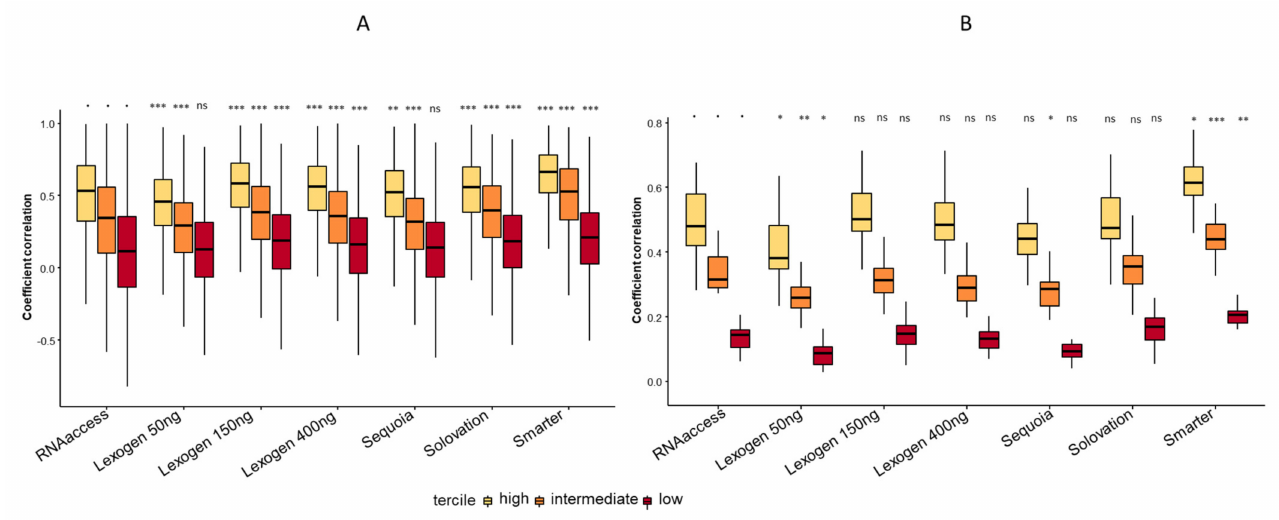
Figure 3. Comparison of sequencing kits with Truseq. ( A ) Gene-wise correlation of gene expressions between Truseq and other sequencing kits. Coefficient correlations of each technique in every tercile were compared using a Mann–Whitney test and using RNAAccess as a comparison. The lower and upper hinges correspond to the first and third quartiles. The upper whisker extends from the hinge to the largest value no further than 1.5 * interquartile range from the hinge. The lower whisker extends from the hinge to the smallest value at most 1.5 * interquartile range of the hinge. . : reference; *: p -value between 0.01 and 0.05. **: p -value between 0.001 and 0.01; ***: p -value < 0.001. ( B ) Sample- wise correlation of samples between Truseq and other sequencing kits. Coefficient correlations of each technique in every tercile were compared using a Mann–Whitney test and using RNAAccess as a comparison. The lower and upper hinges correspond to the first and third quartiles. The upper whisker extends from the hinge to the largest value no further than 1.5 * interquartile range from the hinge. The lower whisker extends from the hinge to the smallest value at most 1.5 * interquartile range of the hinge. . : reference; *: p -value between 0.01 and 0.05. **: p -value between 0.001 and 0.01; ***: p -value <